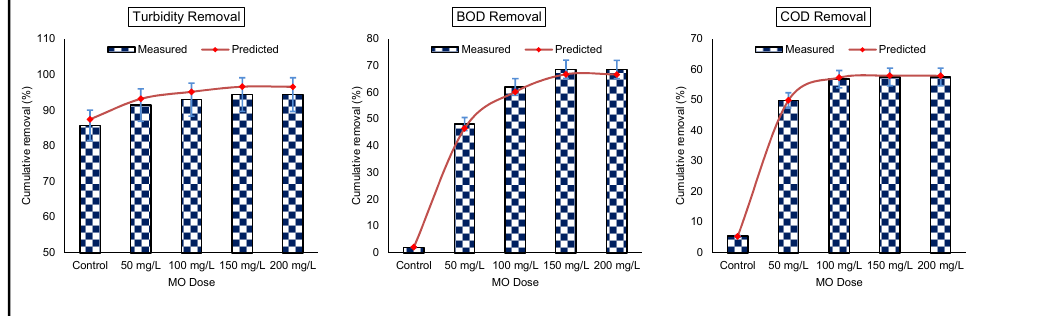
Figure 4. Effect of MO dose with measured versus predicted cumulative removal of turbidity, BOD,